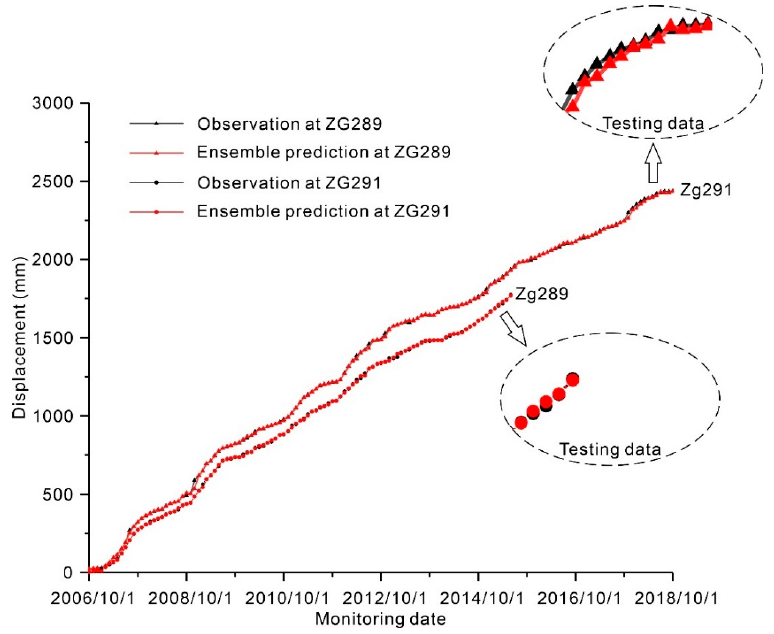
Table 2. Comparisons of predictions obtained from QRNNs-KDE, BP, RBF, ELM, and SVM for the Fanjiaping landslide.